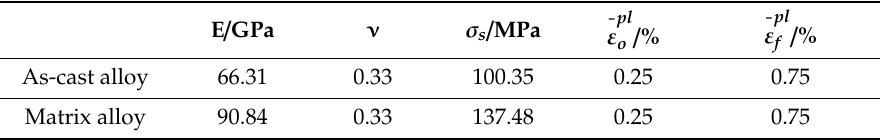
Table 4. Mechanical properties of the as-cast alloy and the matrix alloy.